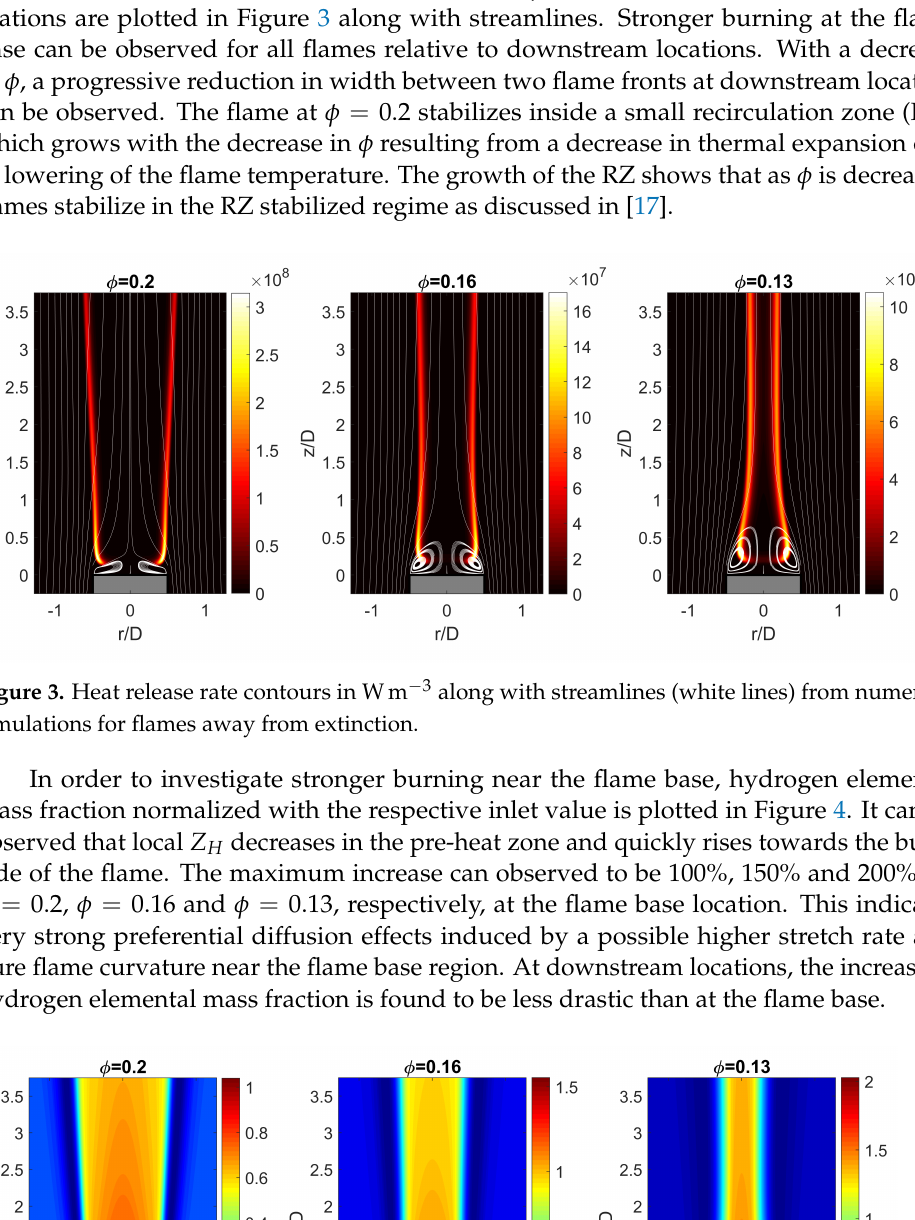
from numerical simulations for flames Z H , in